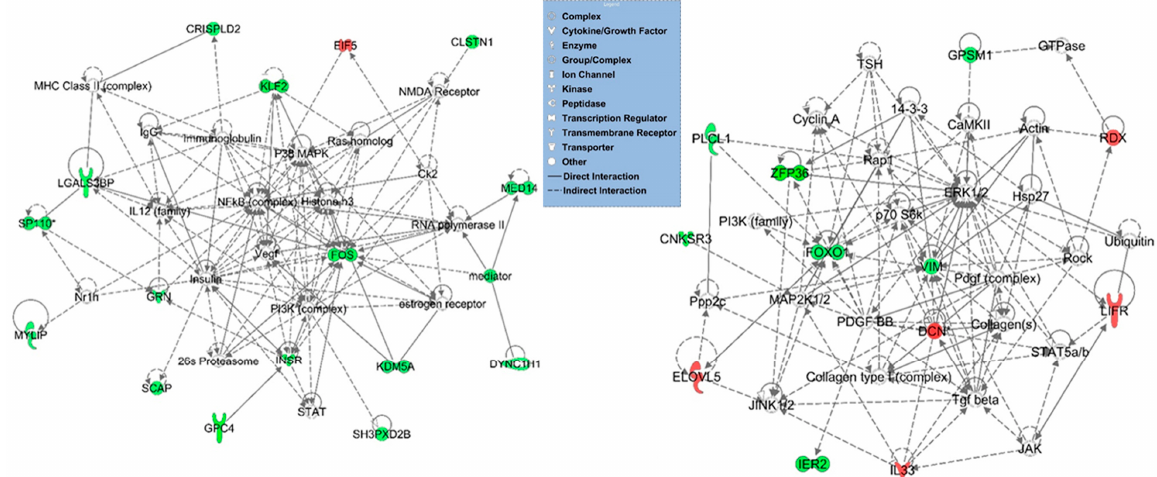
Figure 2. Gene interaction network analysis of significantly dysregulated genes in OHSS group. Top-scoring gene interaction networks with high relevancy scores are shown. Nodes represent genes and the edges indicate biological relationship between the nodes. Straight and dashed lines represent direct or indirect gene-to-gene interactions, respectively. The functional class of the gene product are represented with different shapes (see legend). Red/green indicated up- (down-) regulated in OHSS compared to PCOS group. The color intensity is correlated with fold change.